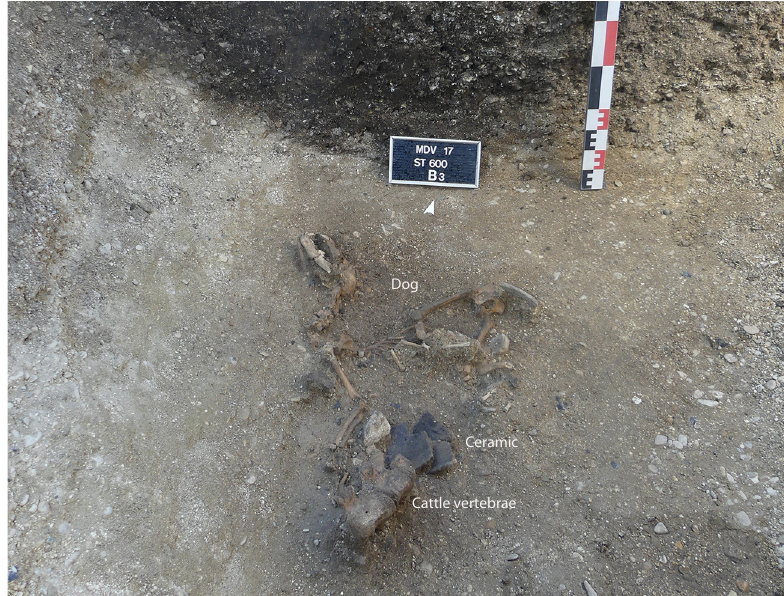
Figure 5: Menneville “ Derrière le Village. ” Dog deposited at the bottom of the ditch, accompanied by sherds and cattle vertebrae, segment 600. Photo UMR 8215 Trajectoires.